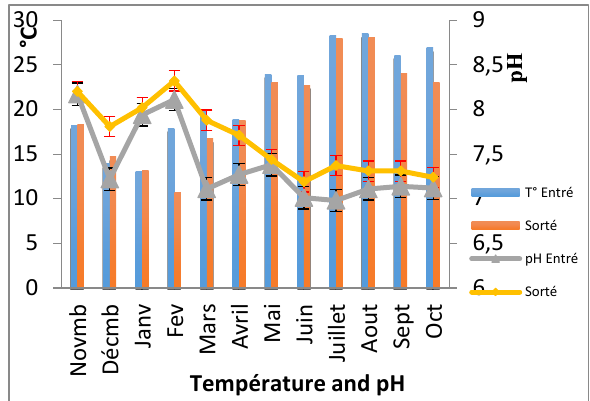
Figure 2. Variation in T and pH values at the entrance and exit of the WWTP